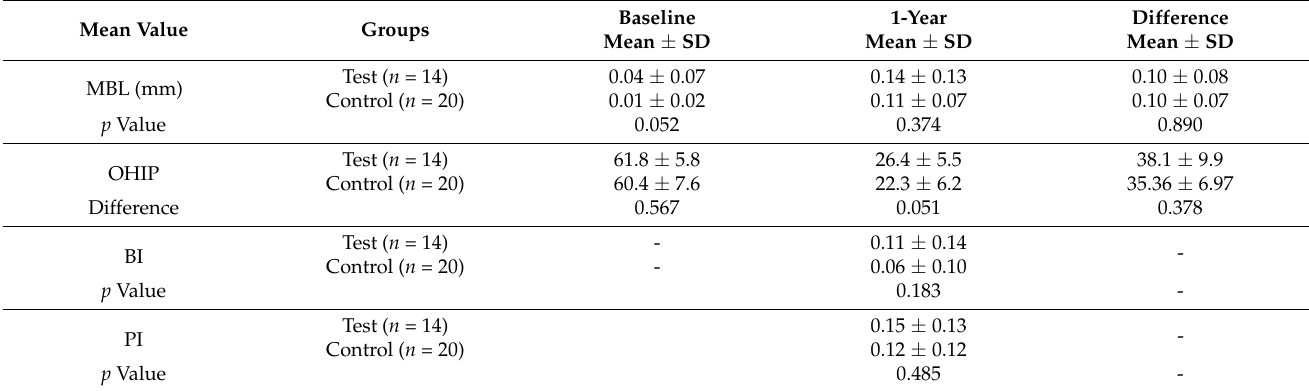
Table 2. Comparison of MBL, OHIP, BI, and PI between